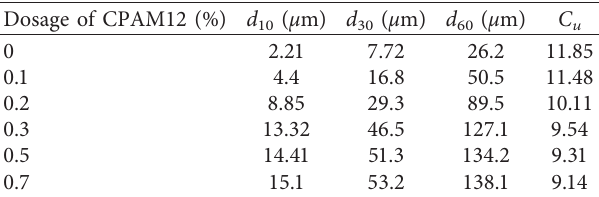
Figure 3 was used to test the effect of slurry pressure fil- tration. The pressure was 0.8 MPa. A water content change curve was compiled (Figure 14). It can be seen that when the